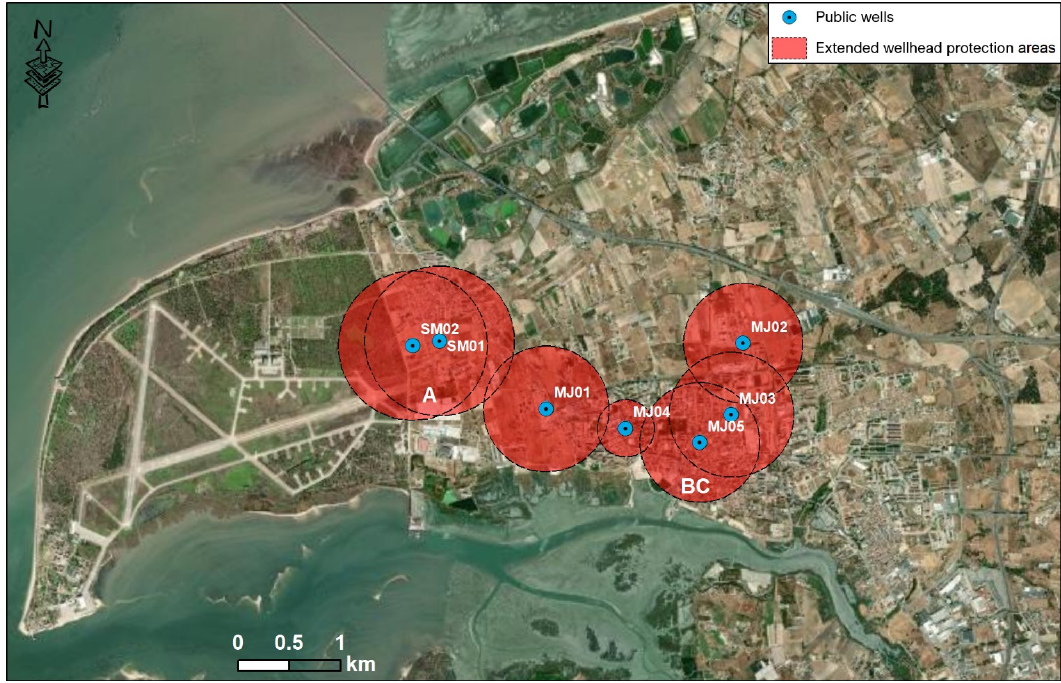
Water 2022 , 14 , x FOR PEER REVIEW Figure 9. Extended wellhead protection zones delimited by the Fixed Radius method.